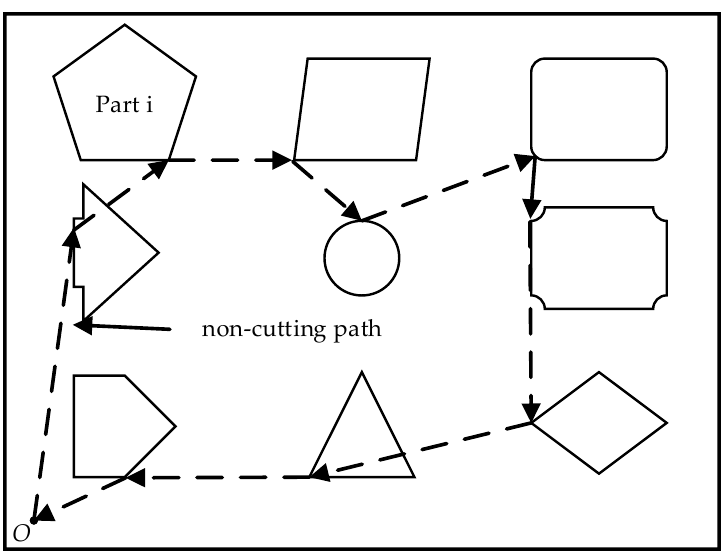
Figure 2. Schematic diagram of laser head non-cutting path.